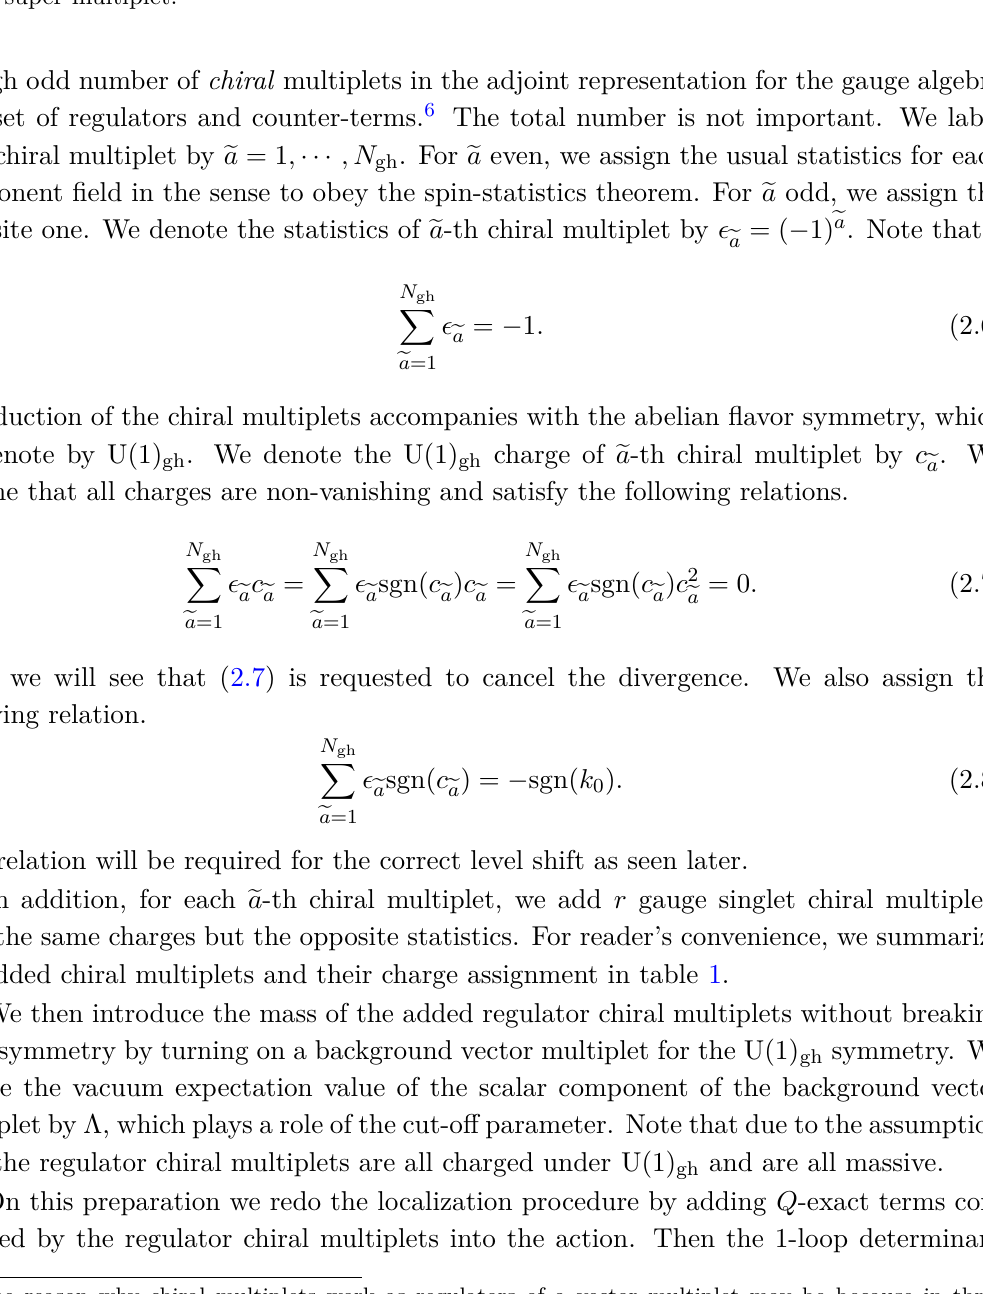
Table 1 . Symmetries and their representation of a vector multiplet and those in regulator chiral multiplets are shown. The charges written in the U(1) R column is that for the fermionic component of the super